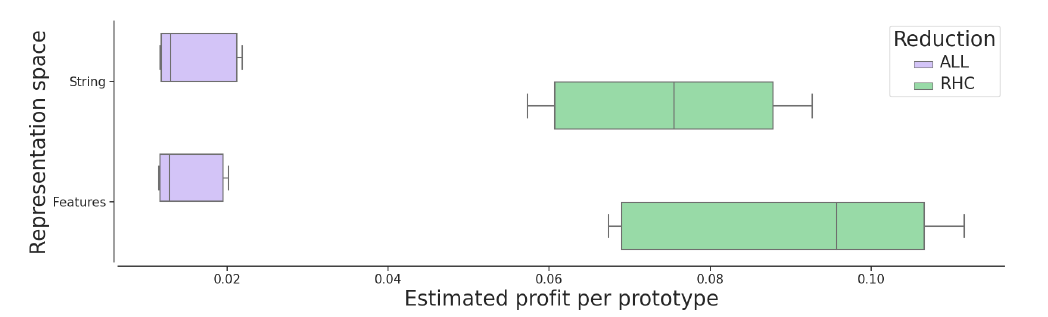
Figure 3. Boxplot graph of the data distributions considered the statistical analysis. Data is grouped according to the representation space considered and the reduction strategy performed (note that ALL stands for the case in which no reduction is performed). All values have been scaled up two orders of magnitude for an easier understanding of the